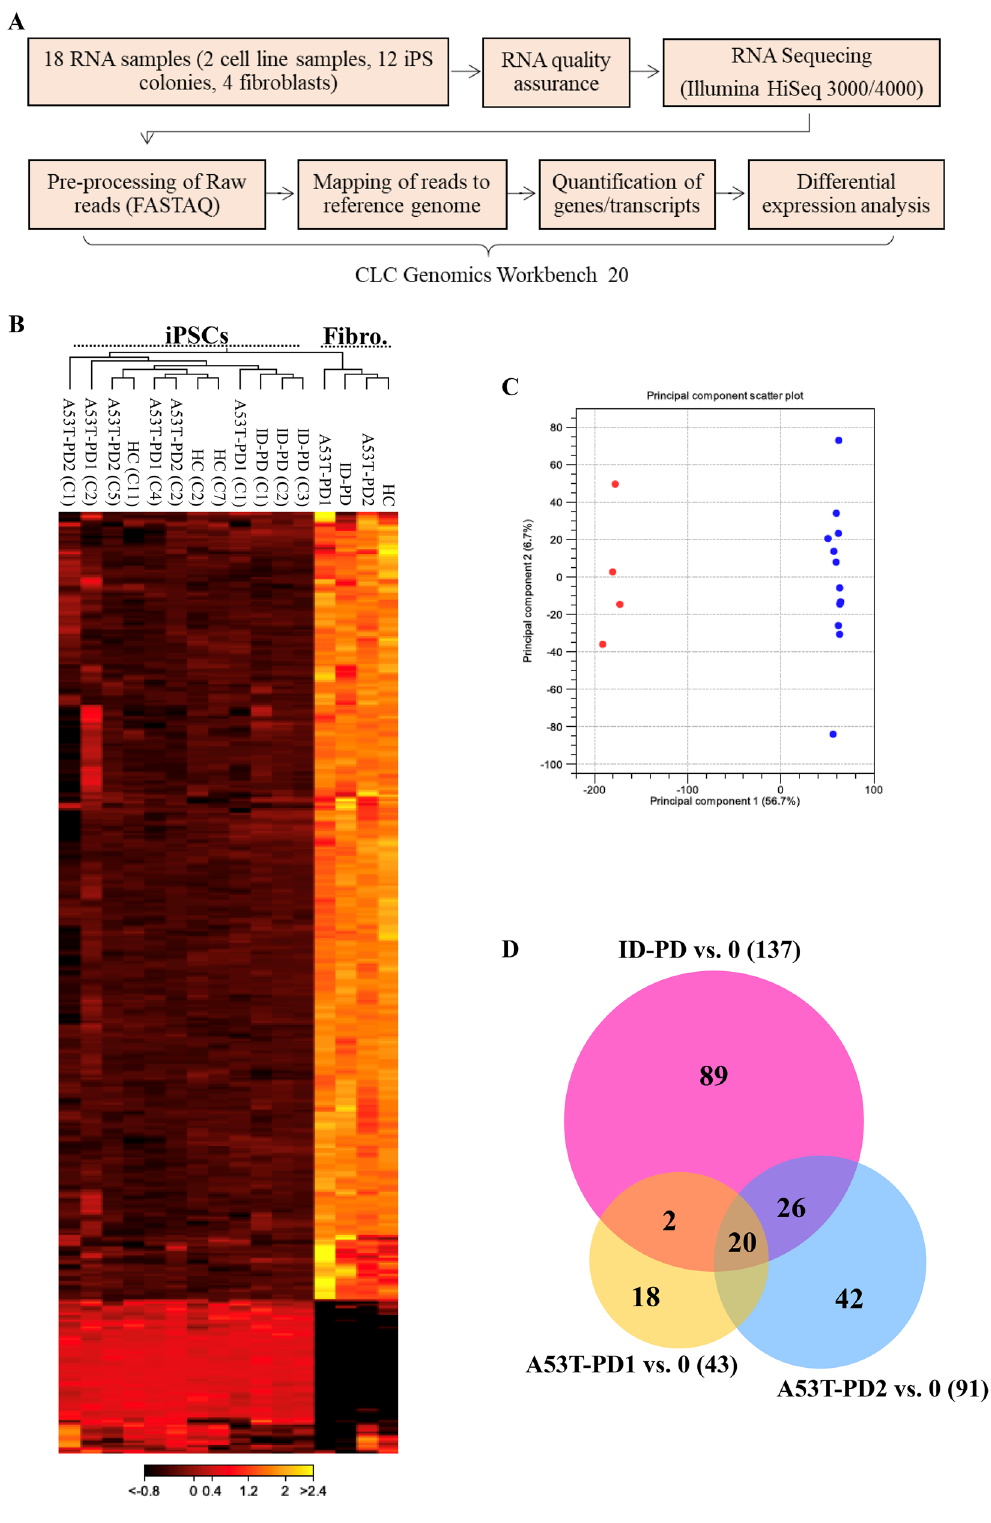
Figure 3. RNA-sequencing identifies transcriptional changes between fibroblasts and iPSCs samples. ( A ) Flowchart of the RNA-Seq and downstream analysis. ( B ) Heatmap analysis for the genes expression levels that showed unique cluster for iPS cell lines and another unique cluster for fibroblasts. ( C ) Two dimensional PCA analysis that shows similarities among fibroblasts and iPS cells; dots highlighted in red and blue represent fibroblasts and iPSCs gene sets; respectively. ( D ) Venn diagram of differentially expressed genes (FDR < 0.01, FC > 2) in the PD iPS cell lines (ID-PD, A53T-PD1 and A53T-PD2) versus control iPS cell line. “0” refers to